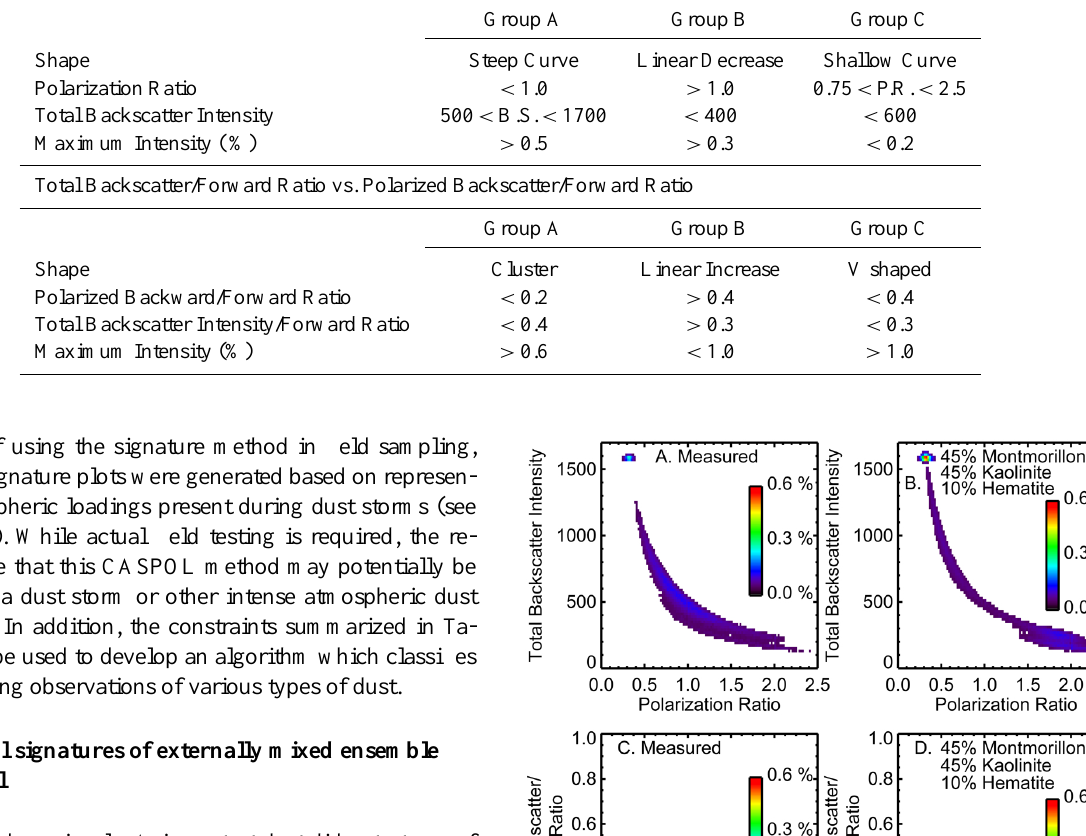
Table 2. Rules for differentiating between dust Groups A, B, and C. Total Backscatter Intensity vs. Polarization Ratio